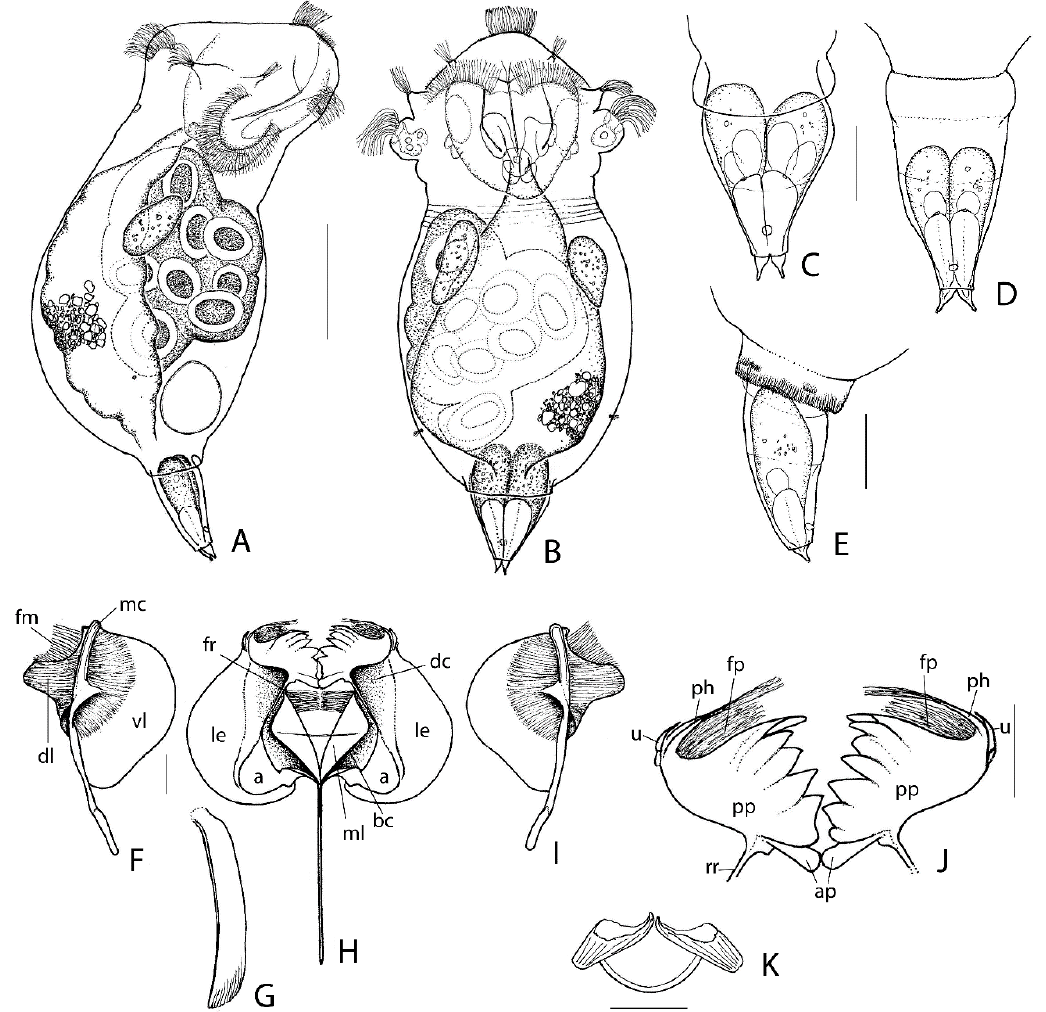
Figure 6. Synchaeta grossa sp. nov., ( A ) Female, lateral. ( B ) Female, dorsal. ( C ) Foot, slightly contracted, dorsal. ( D ) Foot, extended, ventral. ( E ) Foot, extended, lateral right. ( F ) Manubrium, left, outer view. ( G ) Fulcrum, lateral left. ( H ) Incus, ventral. ( I ) Manubrium, right, outer view. ( J ) Pseuduncus, outer view. ( K ) Epipharynx, ventral. a: alula; ap: adjoining platelets; bc: basal ramus chamber; dc: dorsal ramus chamber; dl: dorsal ramus lamella; fm: fimbriae manubrii; fp: fimbriae pseudunci; fr: fimbriae rami; mc: median manubrium chamber; ml: median ramus lamella; le: lamellar ramus extension; ph: pseuduncinal hook; pp: pseuduncinal plate; rr: ramus ridge; u: uncus; vl: ventral lamella. Scale bars: ( A , B ): 50 µm; ( C − E ): 20 µm; ( F − K ): 10 µm. Amictic egg spherical,